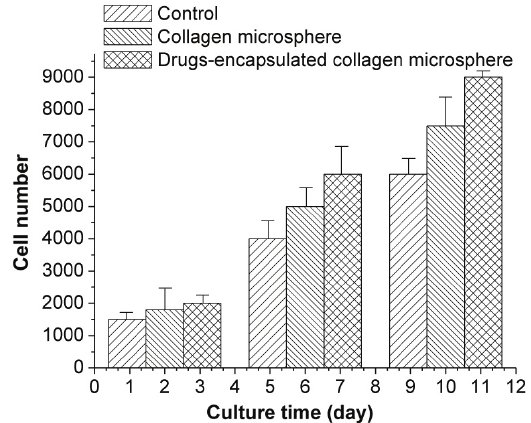
Figure 3. Proliferation of MC3T3-E1 cells on pure collagen microspheres, drugs-encapsulated collagen microspheres and control. At the indicated time points, cell viability of the drugs- encapsulated collagen microsphere group was significantly higher than those of the other two groups. Data are presented as means ± standard deviations for